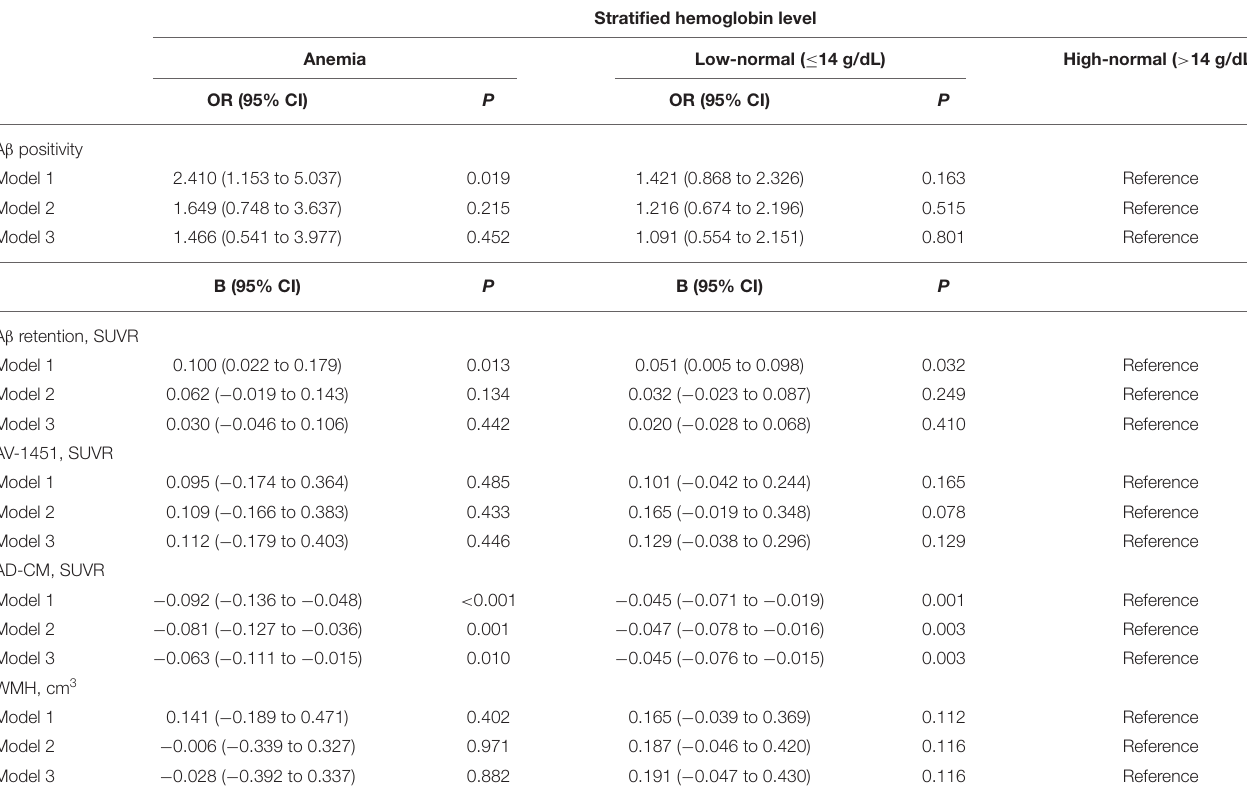
TABLE 3 | Results of multiple logistic and linear regression analyses for assessing the relationship between hemoglobin strata and A β , AV-1451, AD-CM, or WMH in non-demented older adults.